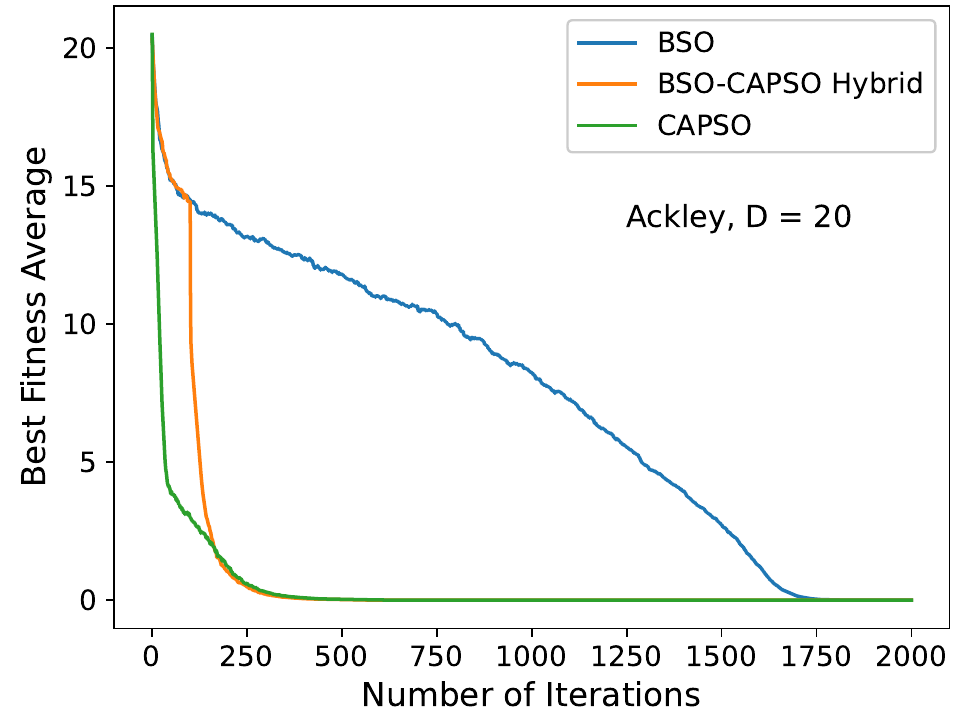
Figure 7. Convergence diagram of the stand-alone BSO, BSO–CAPSO hybrid and stand-alone CAPSO algorithms for the Ackley ( f 5 ) function with D = 20. Convergence acceleration occurred after t switch =